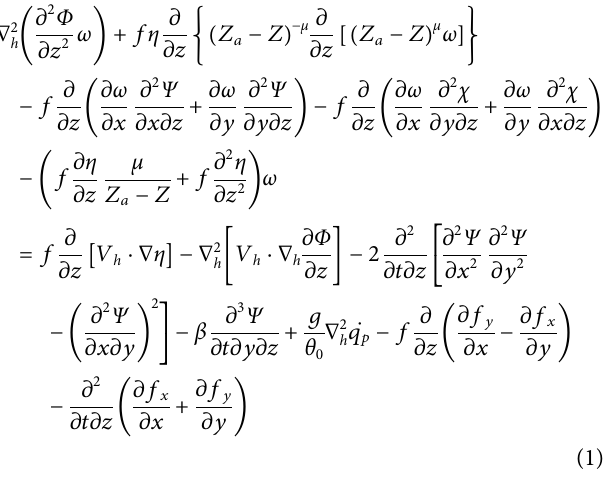
Frontiers in Earth Science |